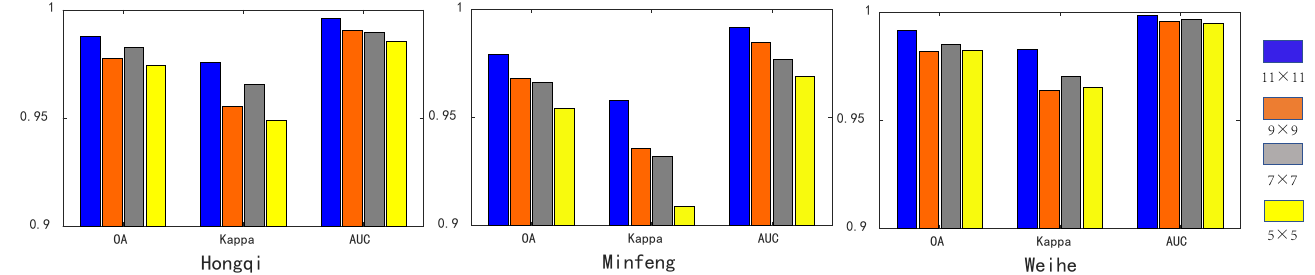
Figure 10. Comparison of the effect of different input patch sizes on OA, Kappa, and AUC values.